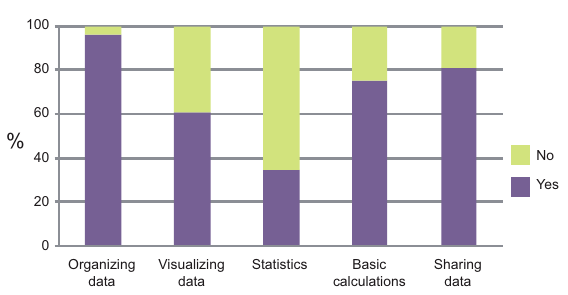
Figure 4. Percent of researchers surveyed who used Excel to perform certain tasks. n = 119.